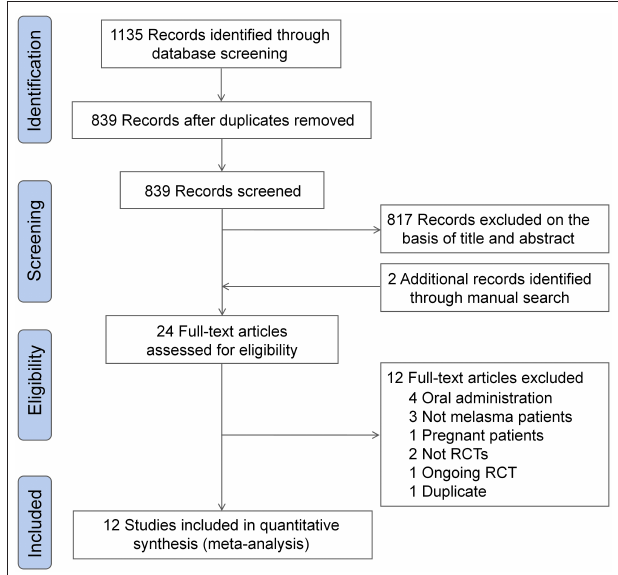
FIGURE 1 | Flow diagram representing the study selection